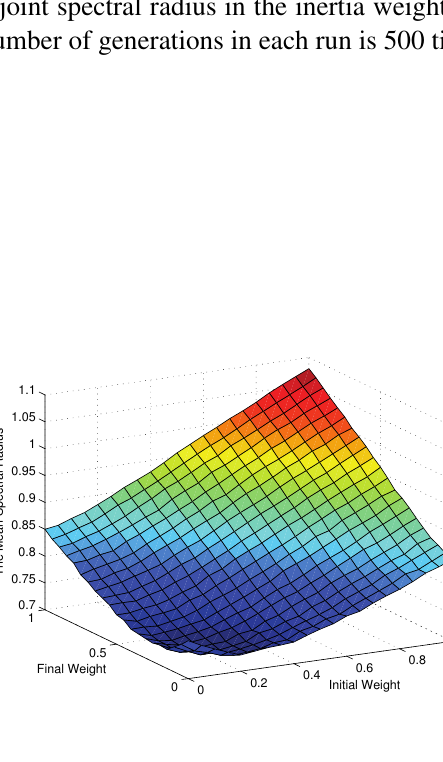
Figure 8: The relationship between Mean ( (cid:7) ) and the range from ω s to ω e , where c 1 , setting to the identical value c 2 , is equal to